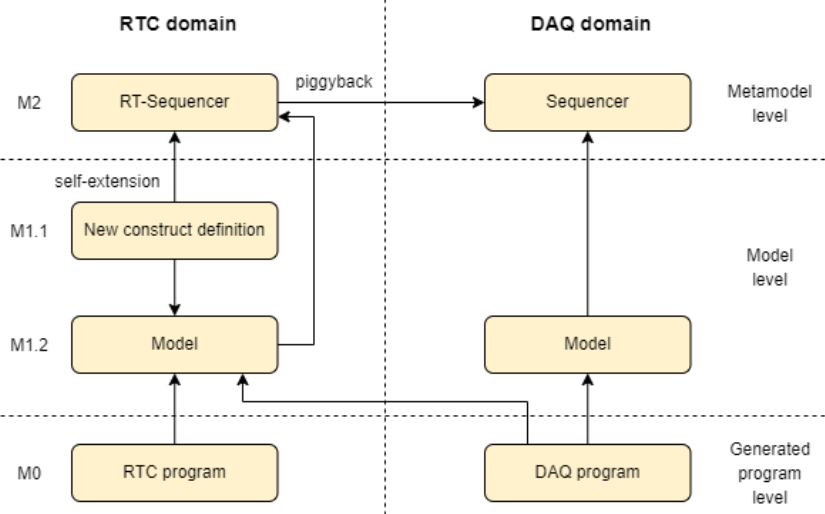
Figure 4. Relation between the Sequencer and